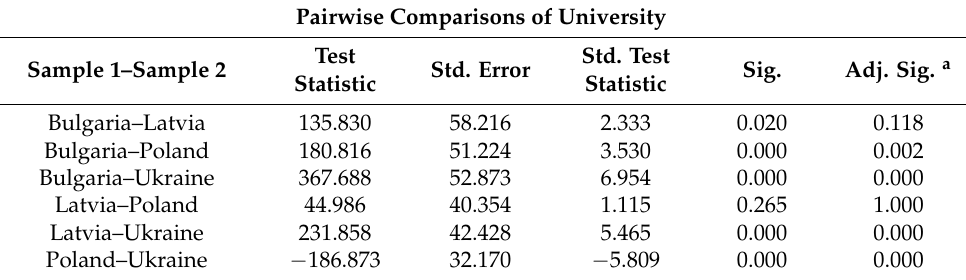
Table 6. Creativity factor—pairwise